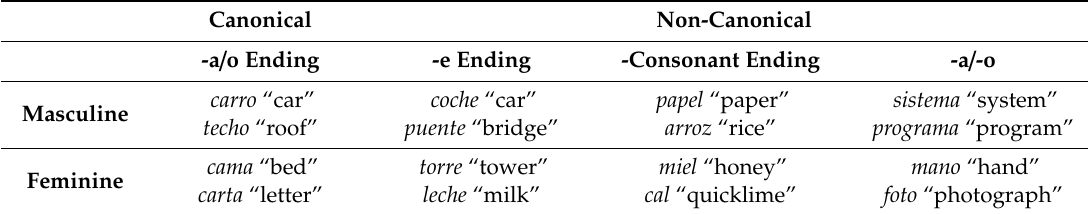
Table 2. Canonical and non-canonical endings in masculine and feminine Spanish